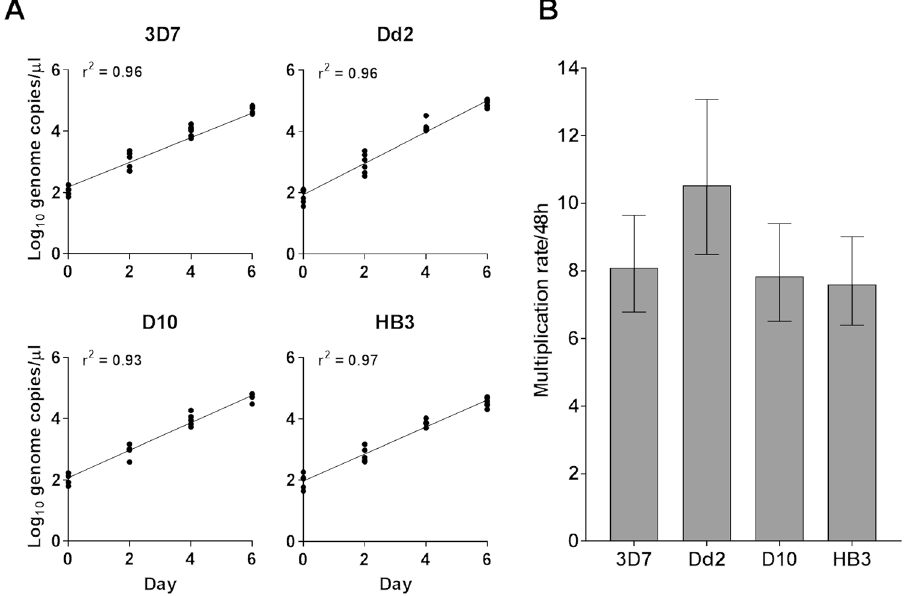
Figure 1. Measurement of exponential multiplication rates of laboratory adapted clones of P. falciparum . ( A ) 6-day growth assays for four laboratory clones, showing parasite density as numbers of genome copies per microlitre (on a log 10 scale). Six biological replicates were performed using different donor erythrocytes. Estimation of parasite copy numbers by quantitative PCR was confirmed to be highly correlated with counts of parasites by microscopy of Giemsa-stained slides (Supplementary Figure S1). ‘3D7’ here refers to the genetically modified clone 3D7-HT-GFP 35 whereas the other clones were not genetically modified. ( B ) General